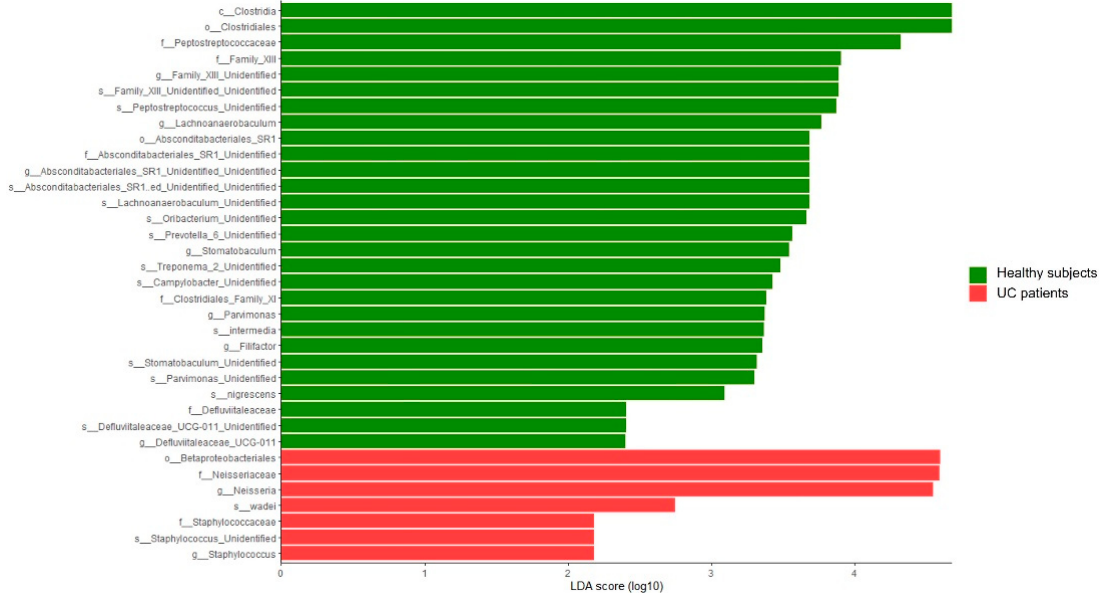
Figure 3. Linear discriminant analysis (LDA) scores (log10) for the significant taxonomic biomarkers obtained from the LEfSe analysis between the groups of healthy subjects and UC patients. Color code: green—taxa in higher proportions in the healthy group; red—taxa in higher proportions in UC participants.